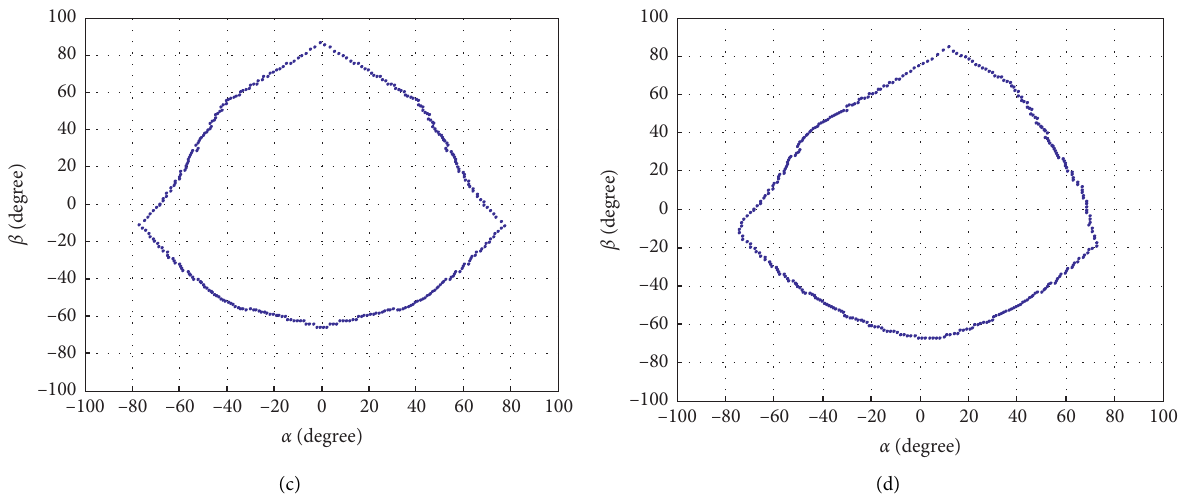
Figure 10: The boundary curves of orientation workspace. (a) ( ( X ) � 9.5, ( Y )� ( Z ) � 0, c � 0), (b) ( ( X ) �− 4.9, ( Y ) �− 14.4, ( Z ) � 0, c � − 4.47 ° ), (c) ( ( X ) �− 19.2, ( Y ) � ( Z ) � 0, c � 0), (d) ( ( X )� − 4.9, ( Y )� 14.4, ( Z ) � − 10, c � 4.47 °